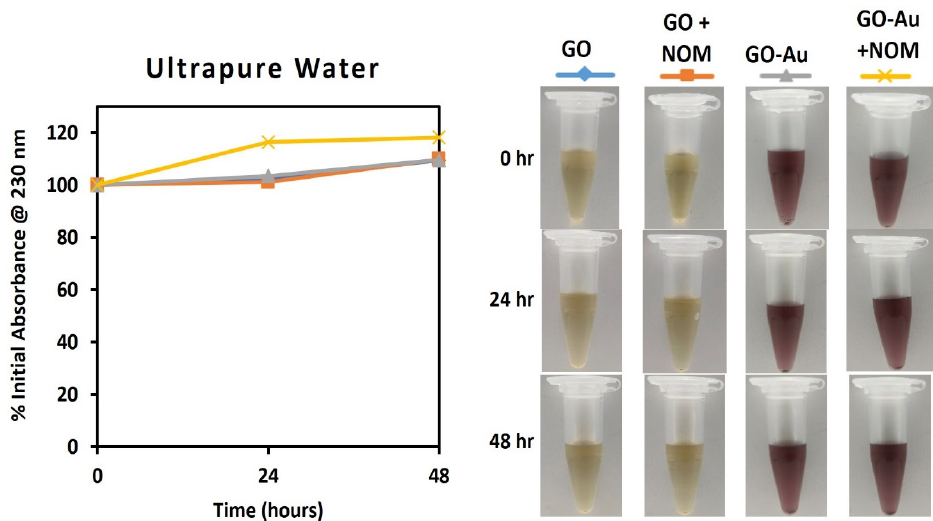
Figure 4. Monitoring of dispersion stability of GO and GO ‐ Au in ultrapure water with and without NOM (20 mg/L). (left): Absorbance measured in UV ‐ vis; (right): Photographs for visual observation.